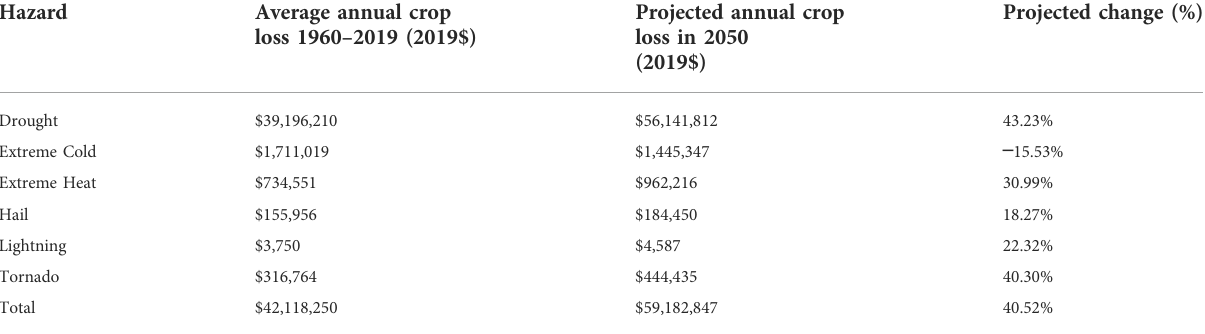
TABLE 9 Comparison of Louisiana statewide crop loss, by hazard: Historical vs.